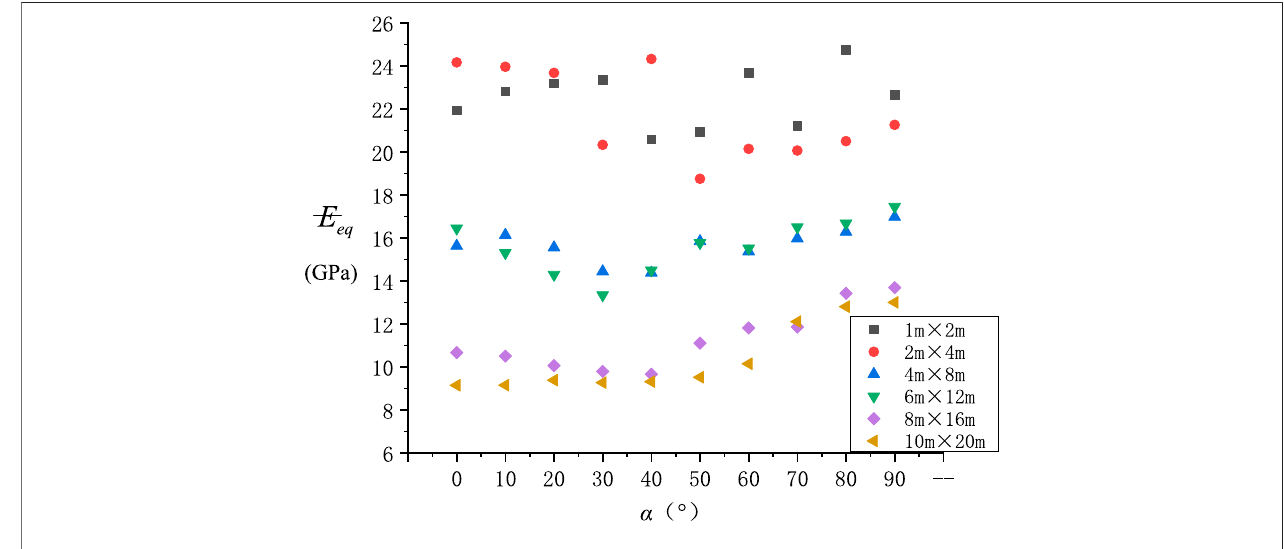
FIGURE 7 | Relationship between the equivalent elasticity modulus and main joint angle α .